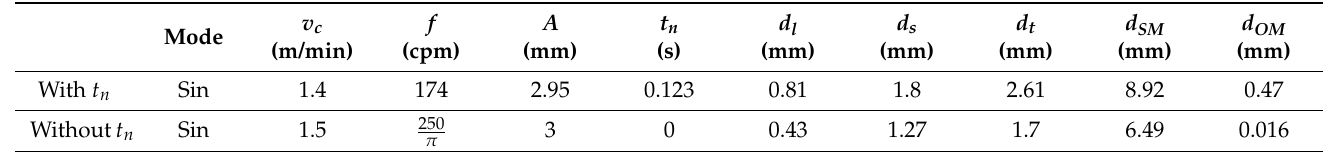
Table 3. Summary of results with and without t n